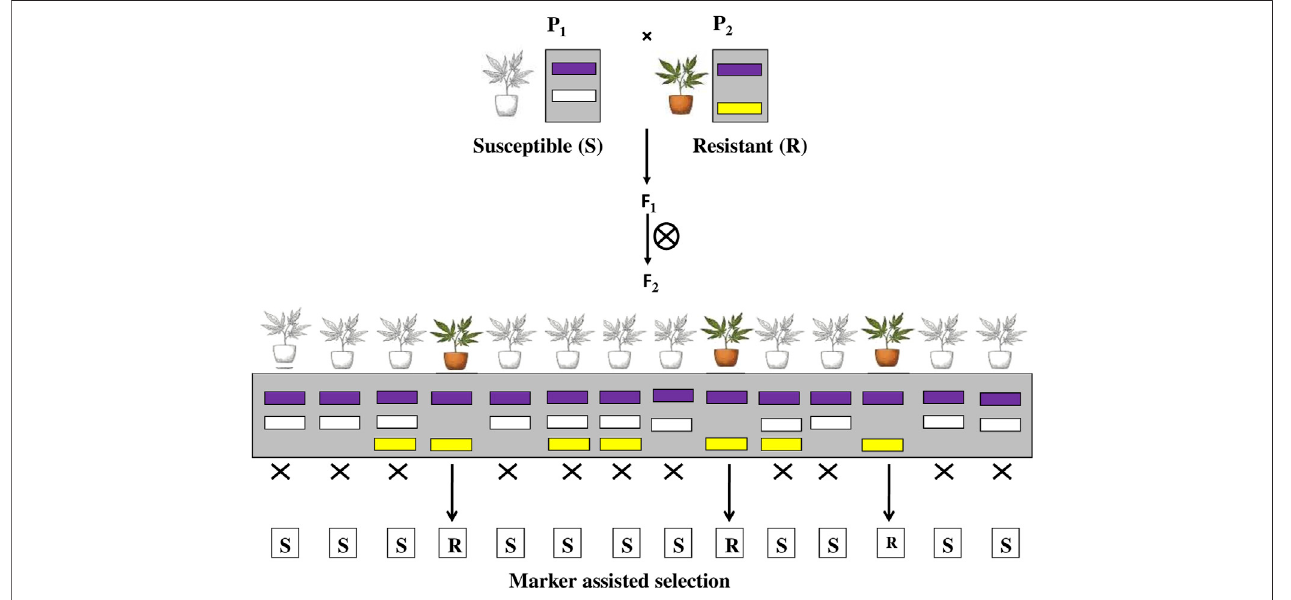
FIGURE 6 | Marker assisted selection and its application in insect pest